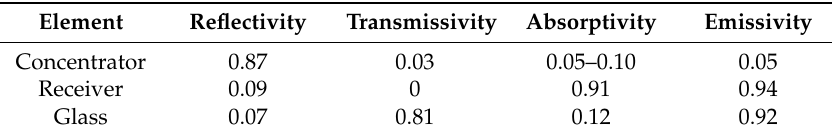
Table 3. Optical properties of the materials used for the CPC construction.